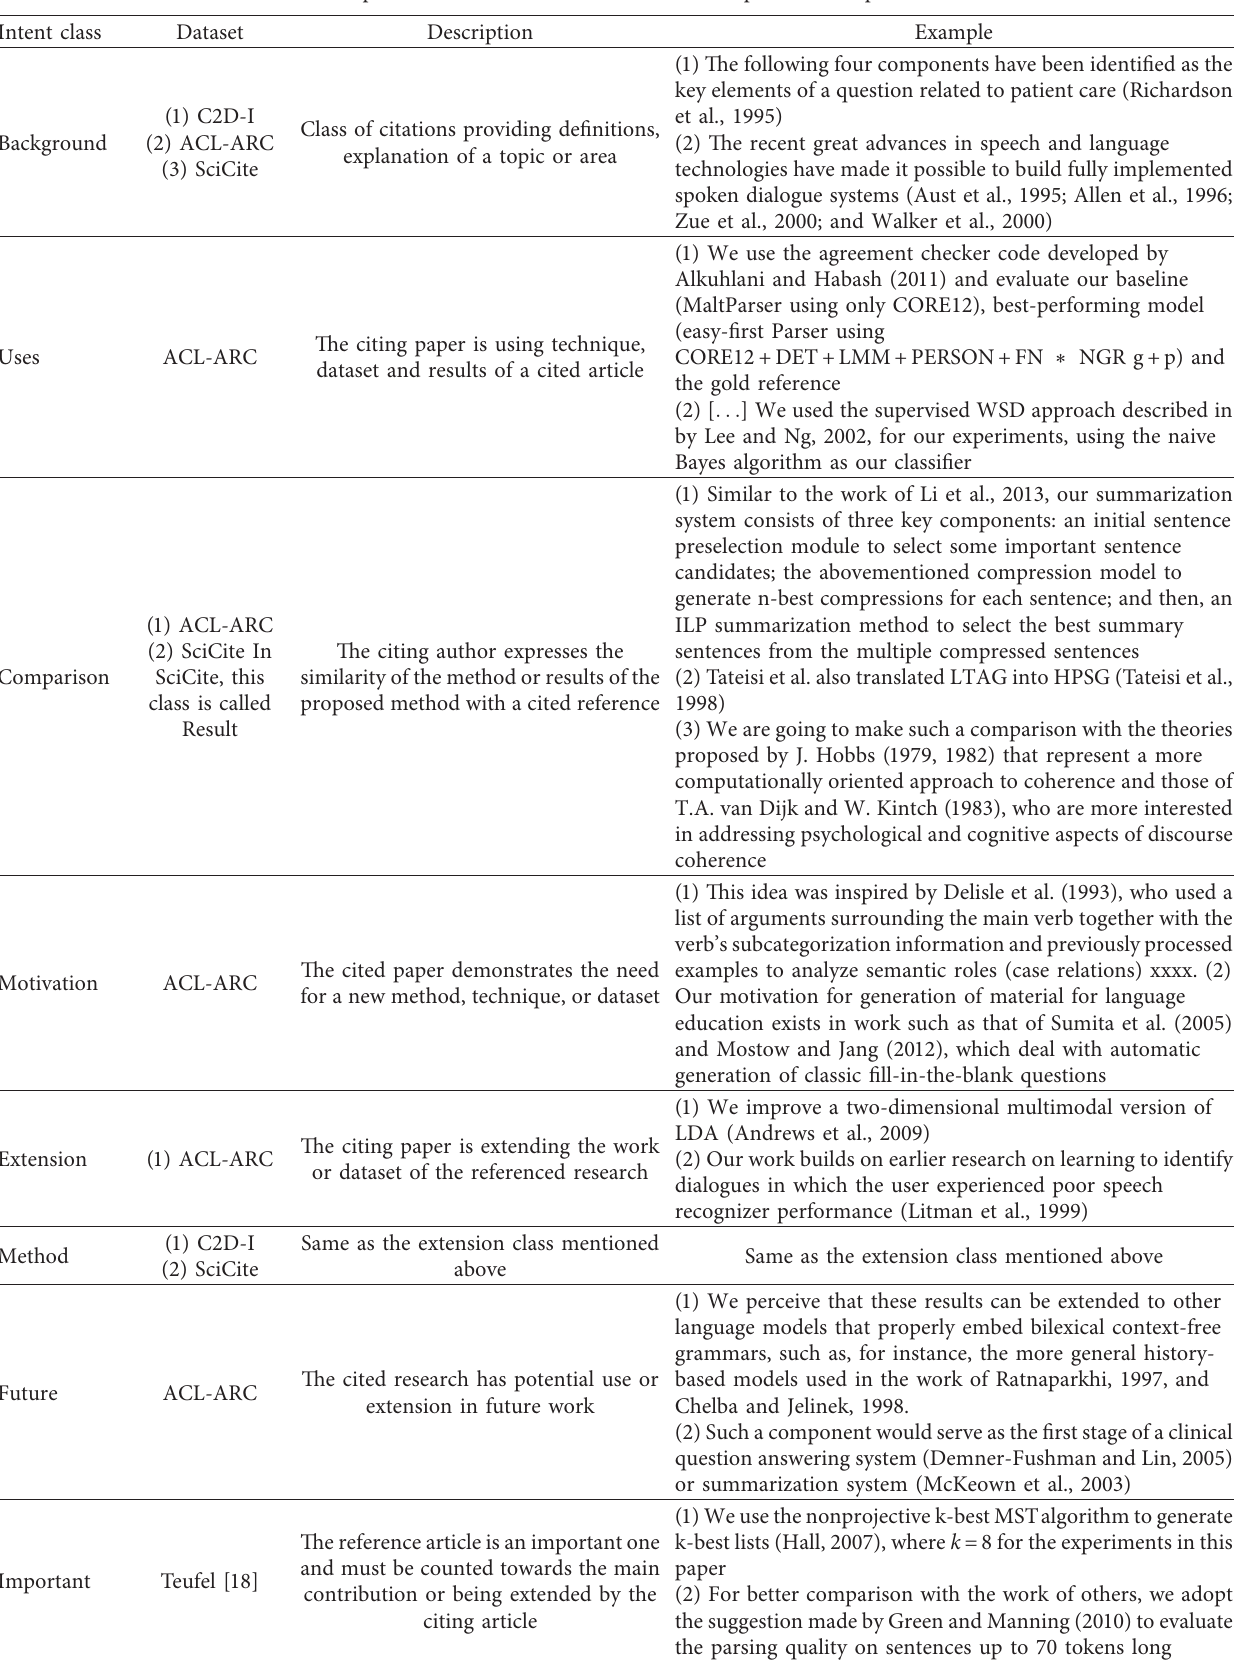
Table 1: Description of citation intent classes with examples from respective